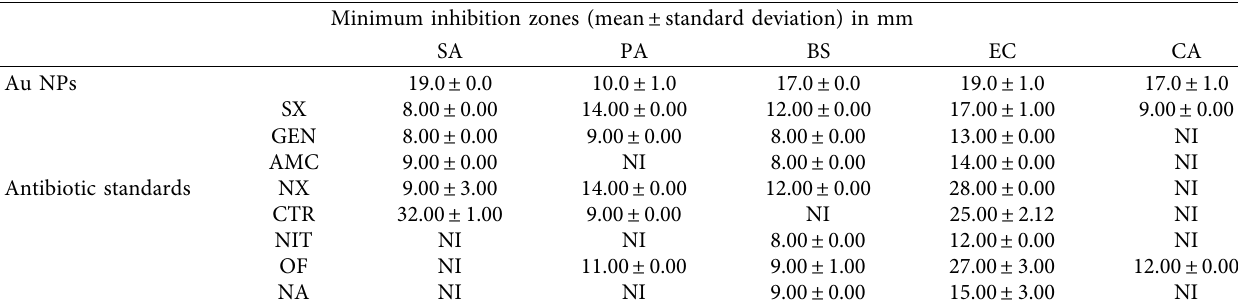
Table 3: Inhibition zones for standard antibiotics compared to Au NPs.